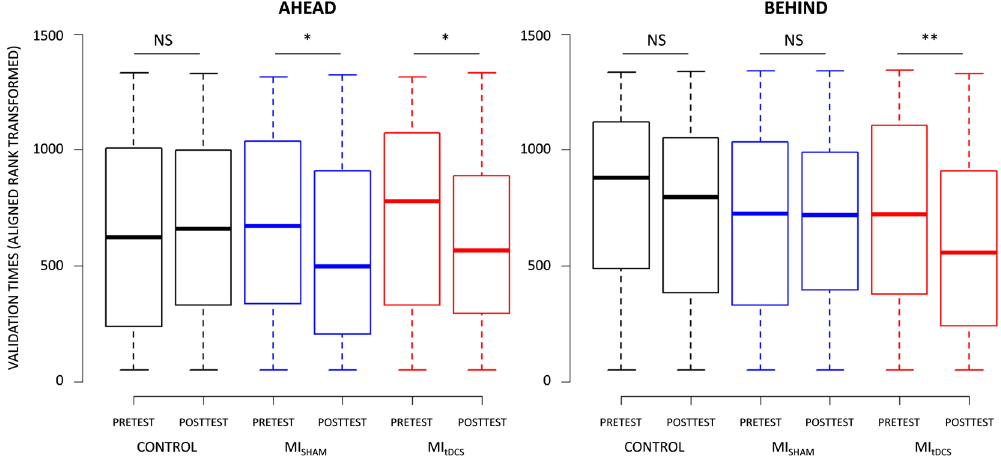
Figure 1. Effect of Control, MI SHAM and MI tDCS conditions on Ahead and Behind targets